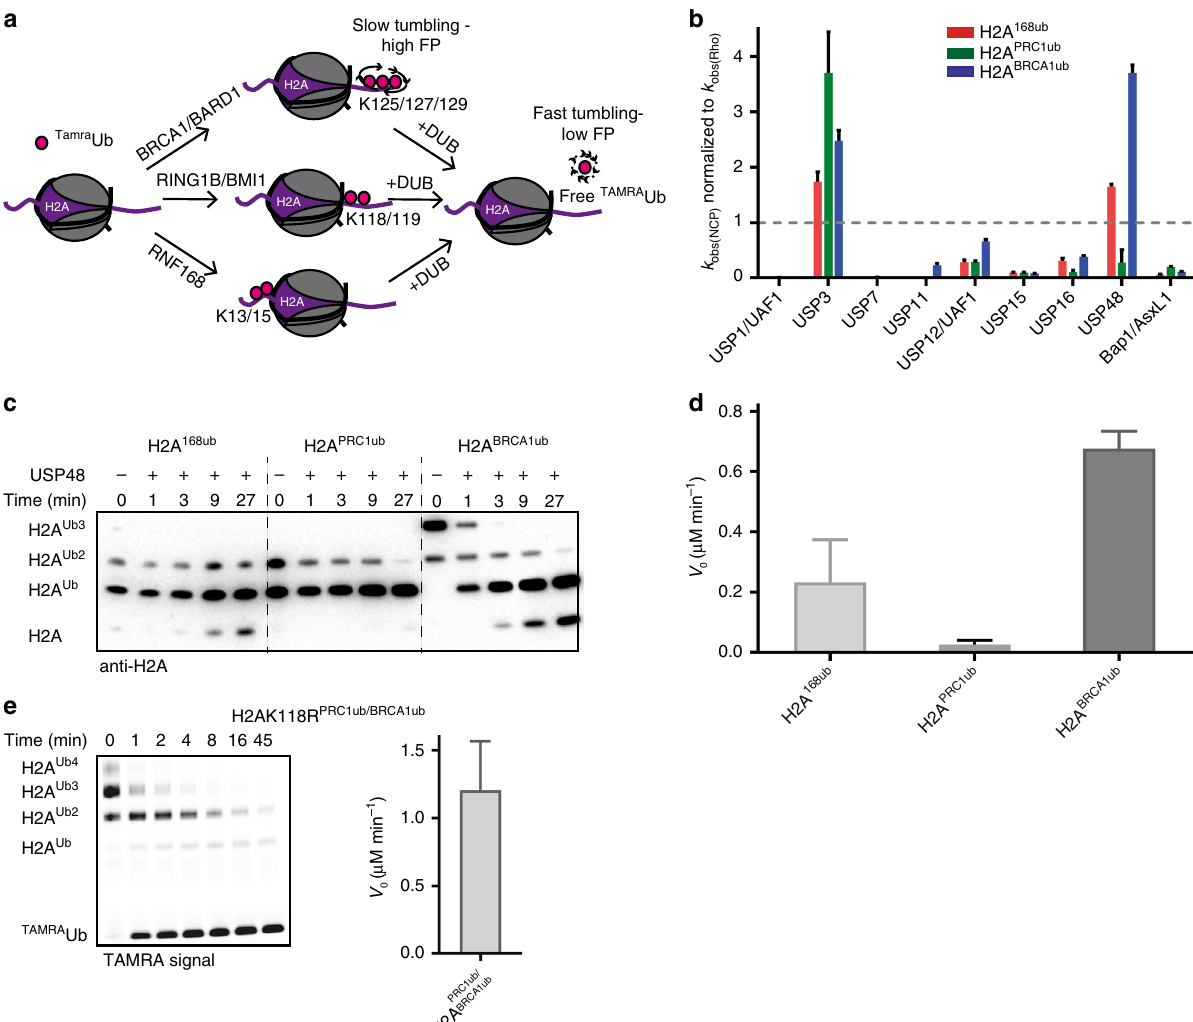
Fig. 1 USP48 speci fi cally deubiquitinates H2ABRCA1ub. a Schematics of the fl uorescence polarization screen. Recombinant nucleosome core particles are site speci fi cally ubiquitinated using the E3 ligase named and TAMRA Ub. Upon addition of a DUB, cleavage can be followed by a decrease in FP signal. b USP48 prefers nucleosomal substrates. Site-speci fi c cleavage of H2A 168ub , H2A PRC1ub , and H2A BRCA1ub in relation to activity on minimal substrate. Observed k- values from fi tting the raw data of the FP assay ( k obs(NCP) ) (Supplementary Fig. 1c) were normalized to observed k- values on minimal substrate ( k obs(Rho) ) obtained from fi tting an exponential function to the traces in Supplementary Fig. 1e). A value above one indicates that NCPs are the preferred substrate. The mean of two technical replicates ± SEM is shown. c Time course of USP48 cleavage of H2A 168ub , H2A PRC1ub , and H2A BRCA1ub , anti-H2A western blotting. USP48 only cleaves ef fi ciently when more than one ubiquitin is present on the BRCA1 site. The blot shown is representative of two experiments. d USP48 cleaves multi-monoubiquitinated H2A BRCA1ub faster than multi-monoubiquitinated H2A 168ub and H2A PRC1ub . Quanti fi cation of the initial reaction velocity ( V 0 ) of USP48 measured by the liberation of free TAMRA Ub. Gels used for quanti fi cation are shown in Supplementary Fig. 2a. The mean of two technical replicates ± SEM is shown. e USP48 does not cleave H2A PRC1ub when H2A BRCA1ub is present, but all H2A BRCA1ub is cleaved. Left panel: cleavage of NCPs, ubiquitinated on PRC1 site with unlabeled ubiquitin, and on the BRCA1 site with TAMRA ub by USP48 was followed on gel. The TAMRA fl uorescence is used as readout. Right panel: quanti fi cation of the initial reaction velocity ( V 0 ) measured by liberation of free ubiquitin. The mean of two technical replicates ± SEM is